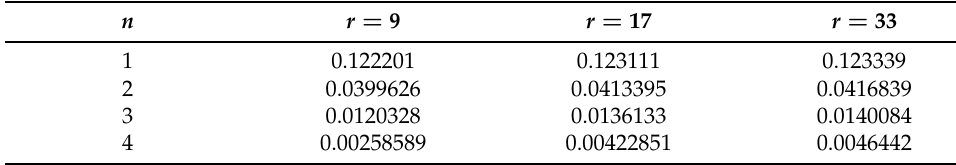
Table 2. (cid:107) F ( x ( n , r ) ) (cid:107) for Example 2 using the usual basis in C [ 0,1 ] . n r = 9 r = 17 r = 33